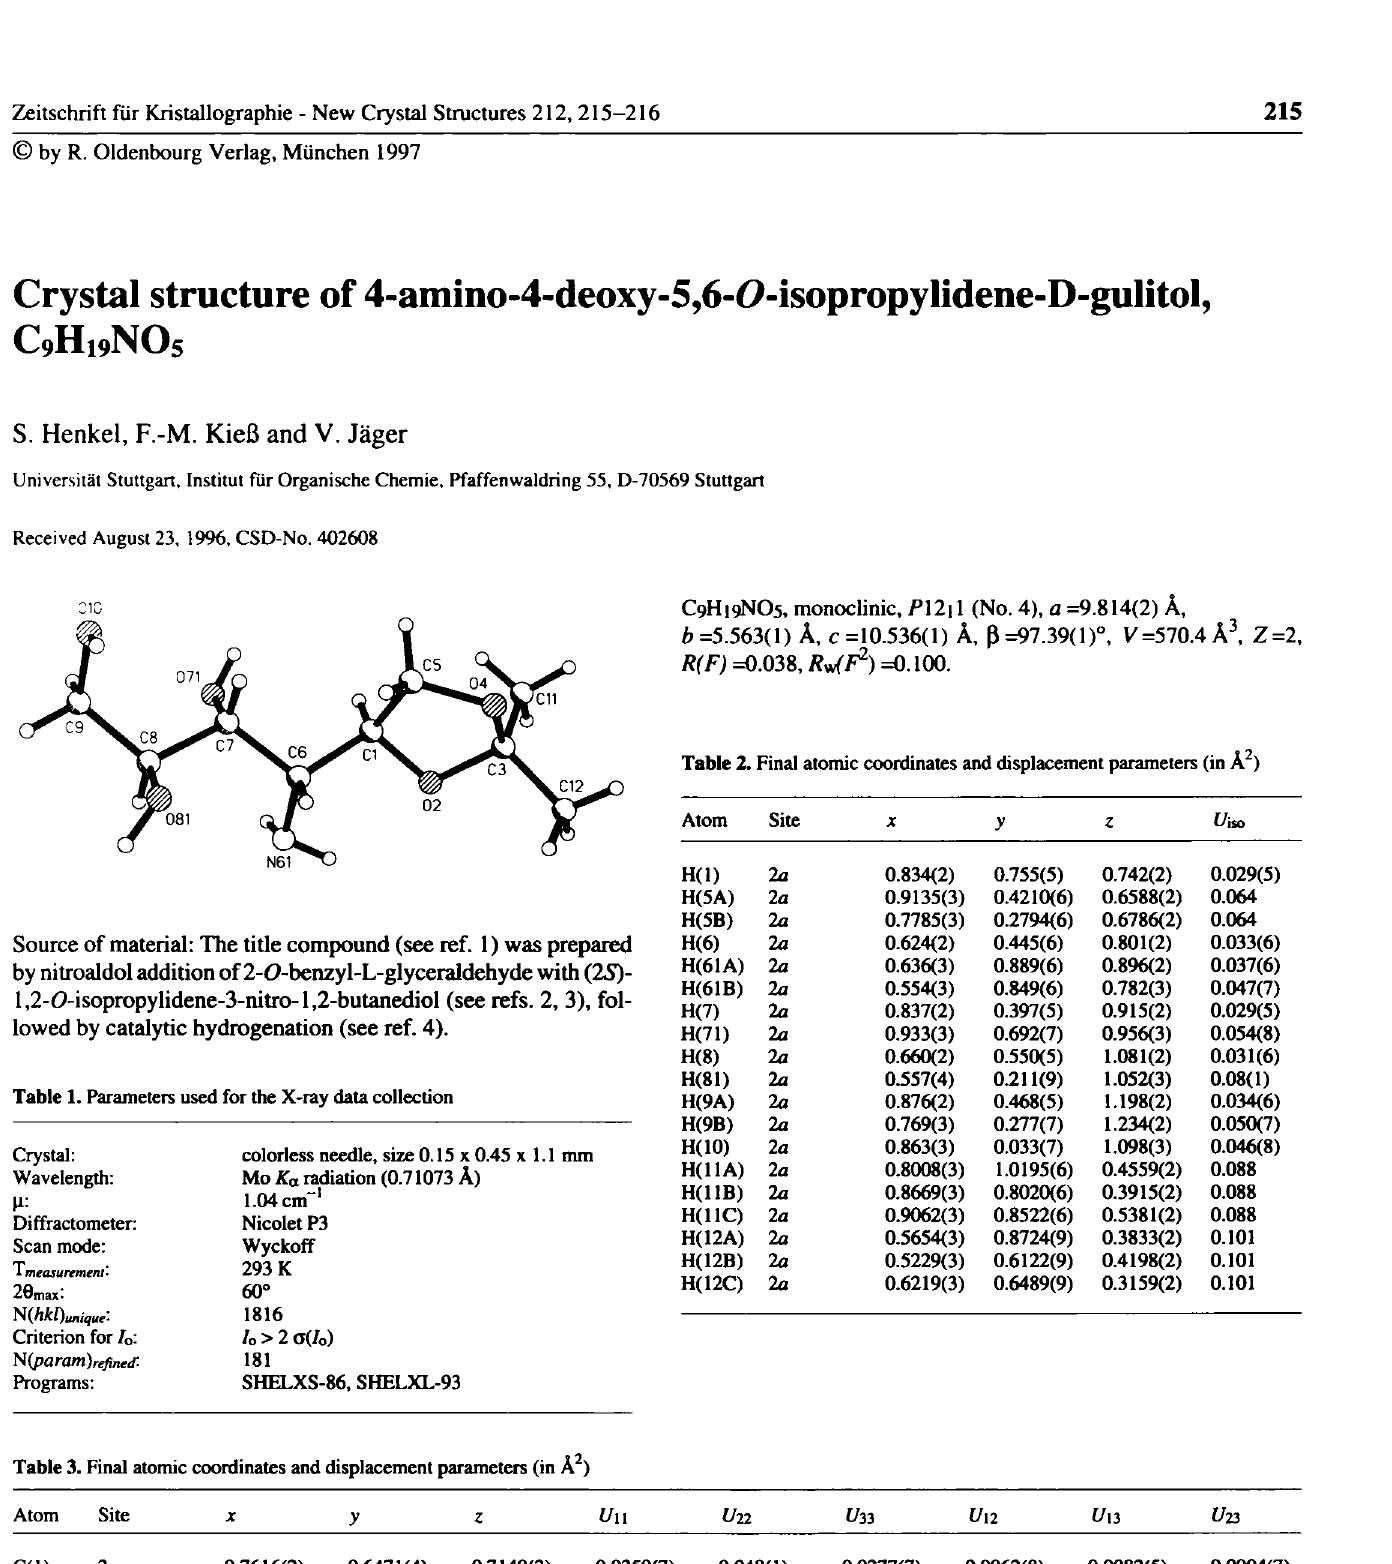
Table 3. Final atomic coordinates and displacement parameters (in Â 2 ) Atom